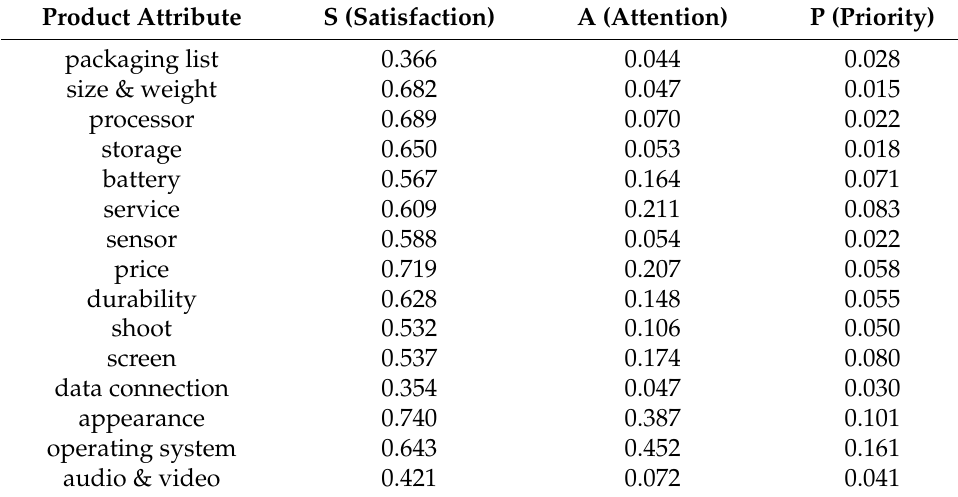
Table 7. Evaluation indicators for the overall 60 smartphones.